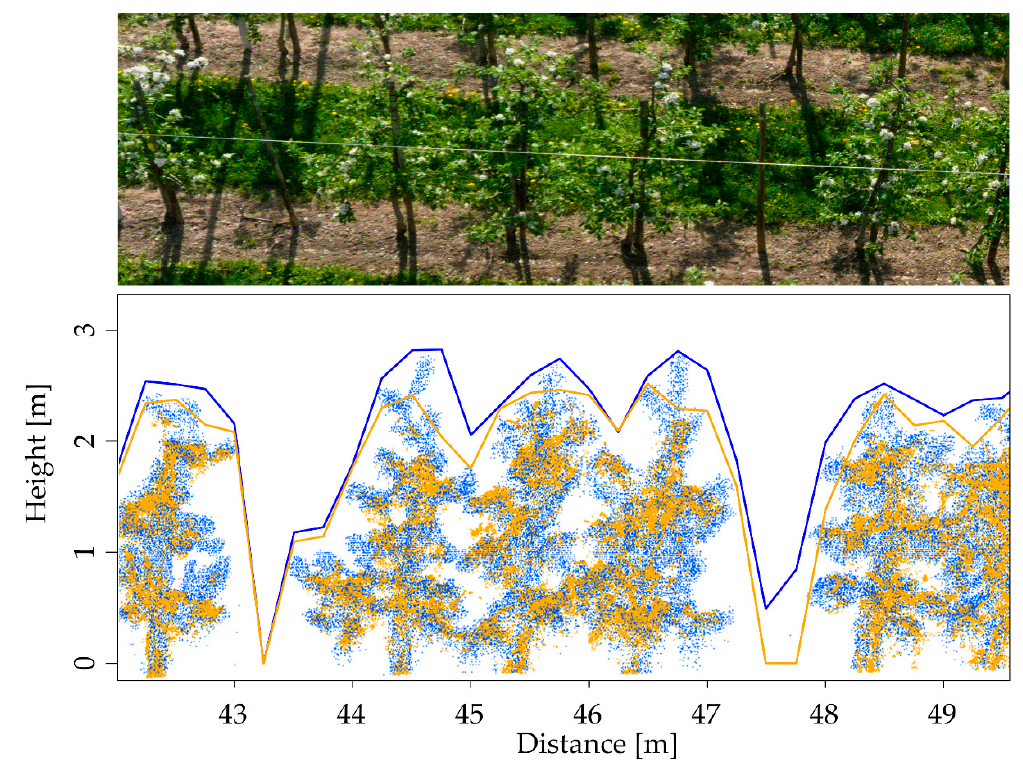
Figure 6. Detailed view of row A (42–50 m) in 2019 as an RGB image ( top ) and point clouds from UAV (orange) and LiDAR (blue) data superimposed with tree wall height curves from UAV (orange) and LiDAR (blue) model ( bottom ).